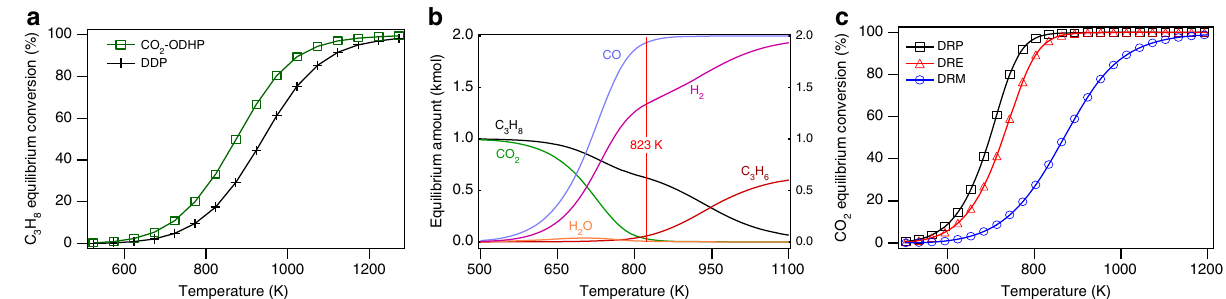
Fig. 1 Thermodynamic equilibrium plots. Equilibrium calculations were performed through HSC Chemistry 8 software, which utilizes a Gibbs free energy minimization algorithm. a C 3 H 8 equilibrium conversion for CO 2 -ODHP and direct dehydrogenation of propane; b product amounts for CO 2 + C 3 H 8 system and c conversions of propane, ethane, and methane dry reforming; all vs. temperature at 1